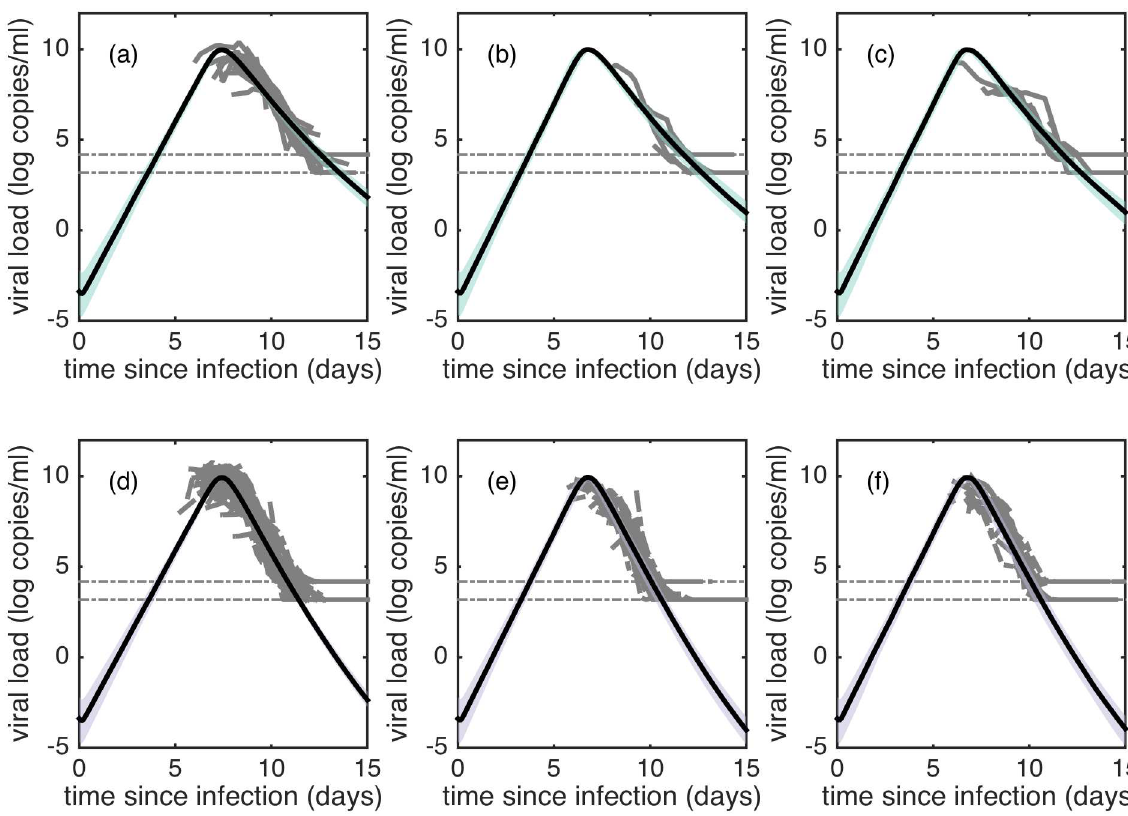
Fig 6. Fits of model SS β to viral load data. (a-f) Model simulations alongsideviral load measurements from all individuals experiencing a DENV-1 (a,d), DENV-2 (b,e), or DENV-3 (c,f) infection. Primary infection simulations and data are shown in (a-c). Secondary infection simulations and data are shown in (d-f). Gray lines show primary infection data (a-c) and secondaryinfection data (d-f). Green and purple shaded regionsshow 95% posterior credibleintervals of primary and secondaryinfections, respectively. Credibleintervals were constructed from 100 simulations of model SS β , where parameters are sampled from the posterior for each simulation. Black lines show simulations using median likelihoodparametersestimates. In all subplots, dotted horizontal lines show limits of detection. As in Fig 2a and 2b, viremia measurements are shifted in time based on sampled estimates of individual IP